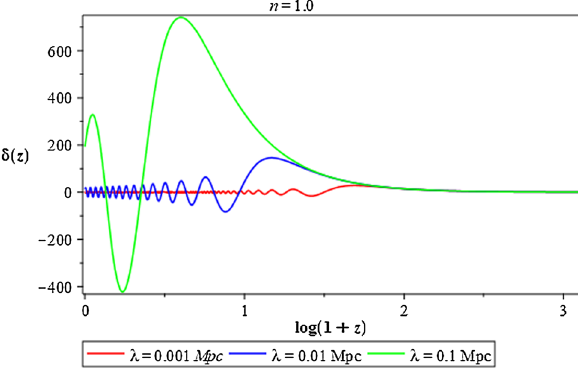
Fig. 10 δ( z ) versus z for Eq. (112) for short-wavelength mode for different λ at n = 1